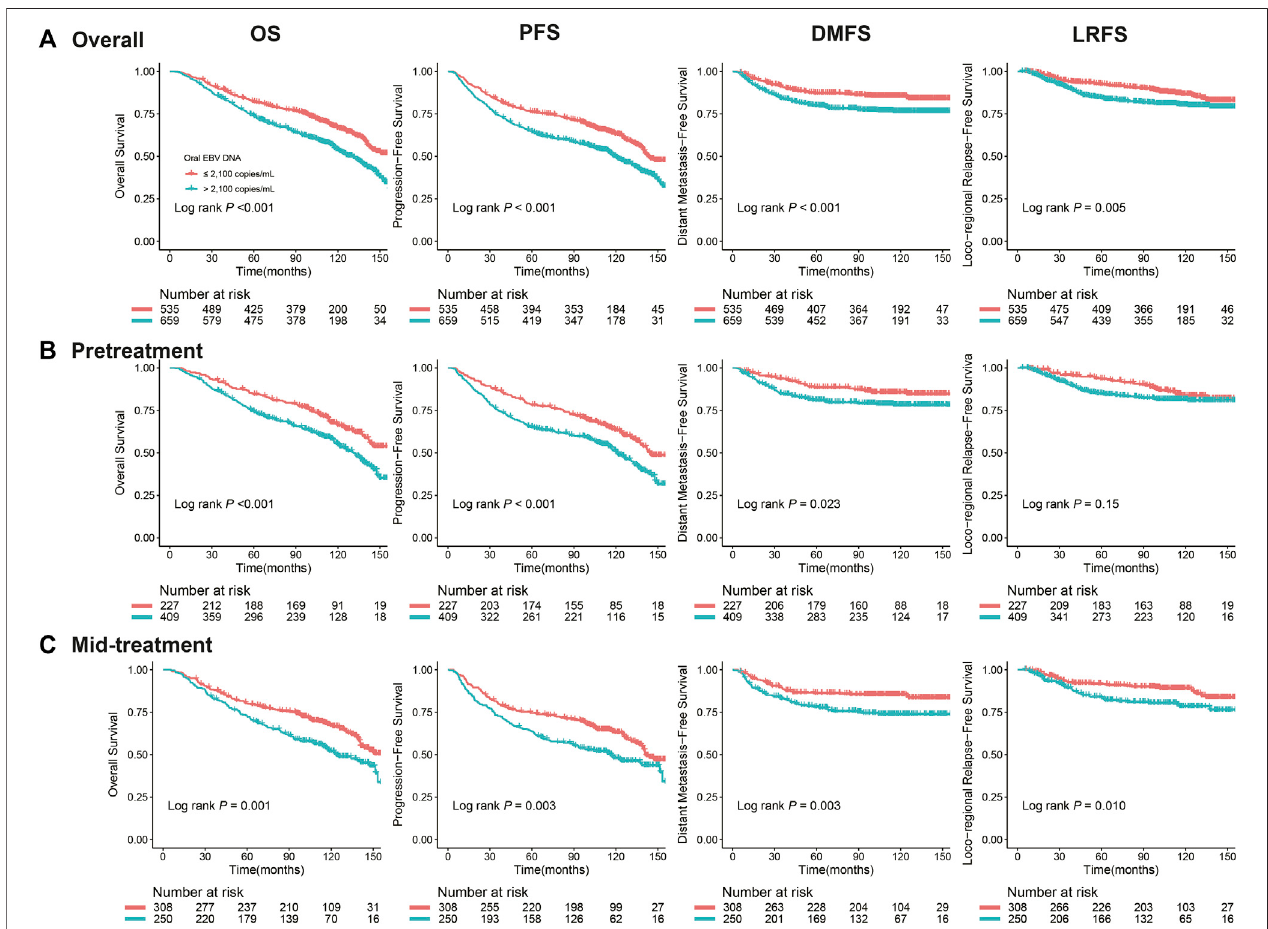
FIGURE2| Kaplan – Meiercurves forNPC survivalsegregated bytheoral EBVDNA level atdifferenttreatment time points: (A) overall, (B) pretreatment, beforeany treatment, (C) mid-treatment, between the start of treatment and the end of radiotherapy/chemoradiotherapy. Survivals included overall survival (OS), progression-free survival (PFS), distant metastasis – free survival (DMFS), and locoregional relapse-free survival (LRFS).